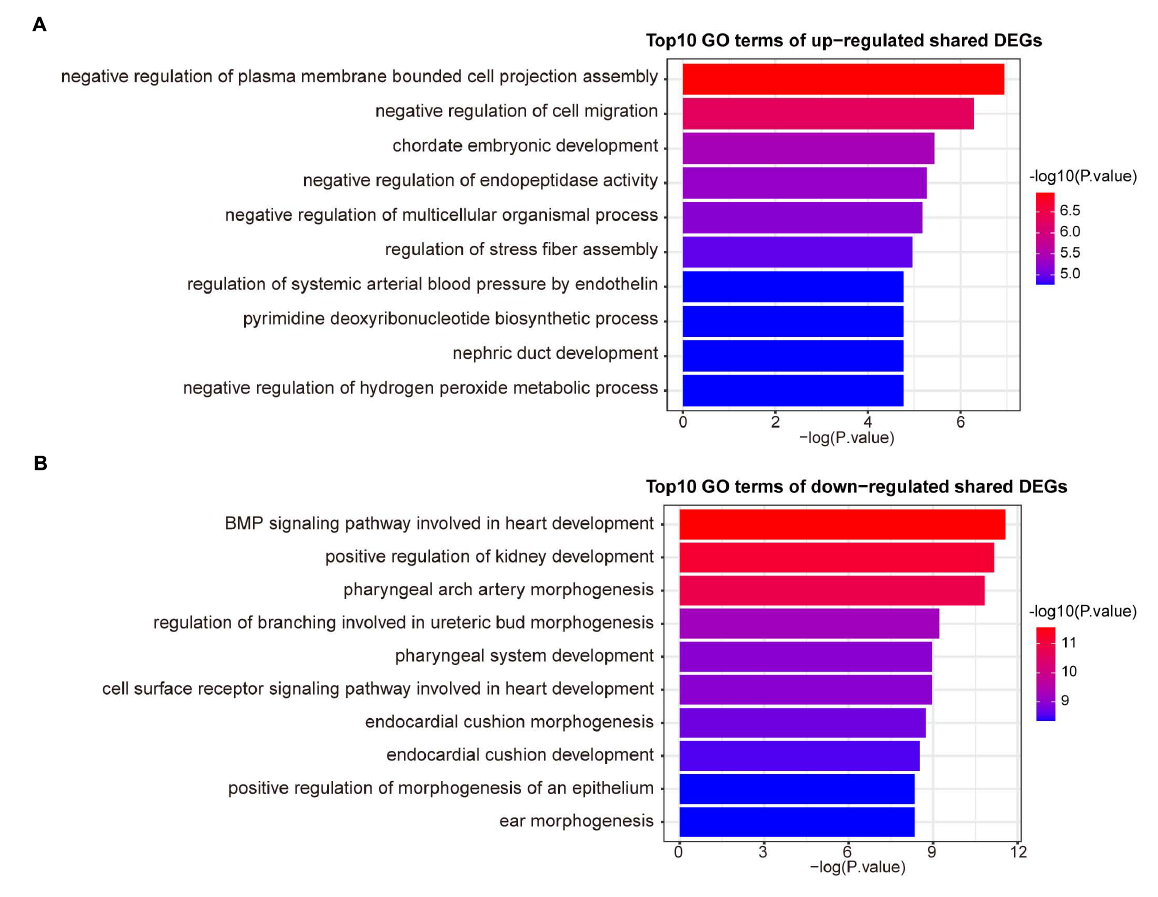
FIGURE4 The top 10 GO biological processes terms of up-regulated (A) and down-regulated (B) shared